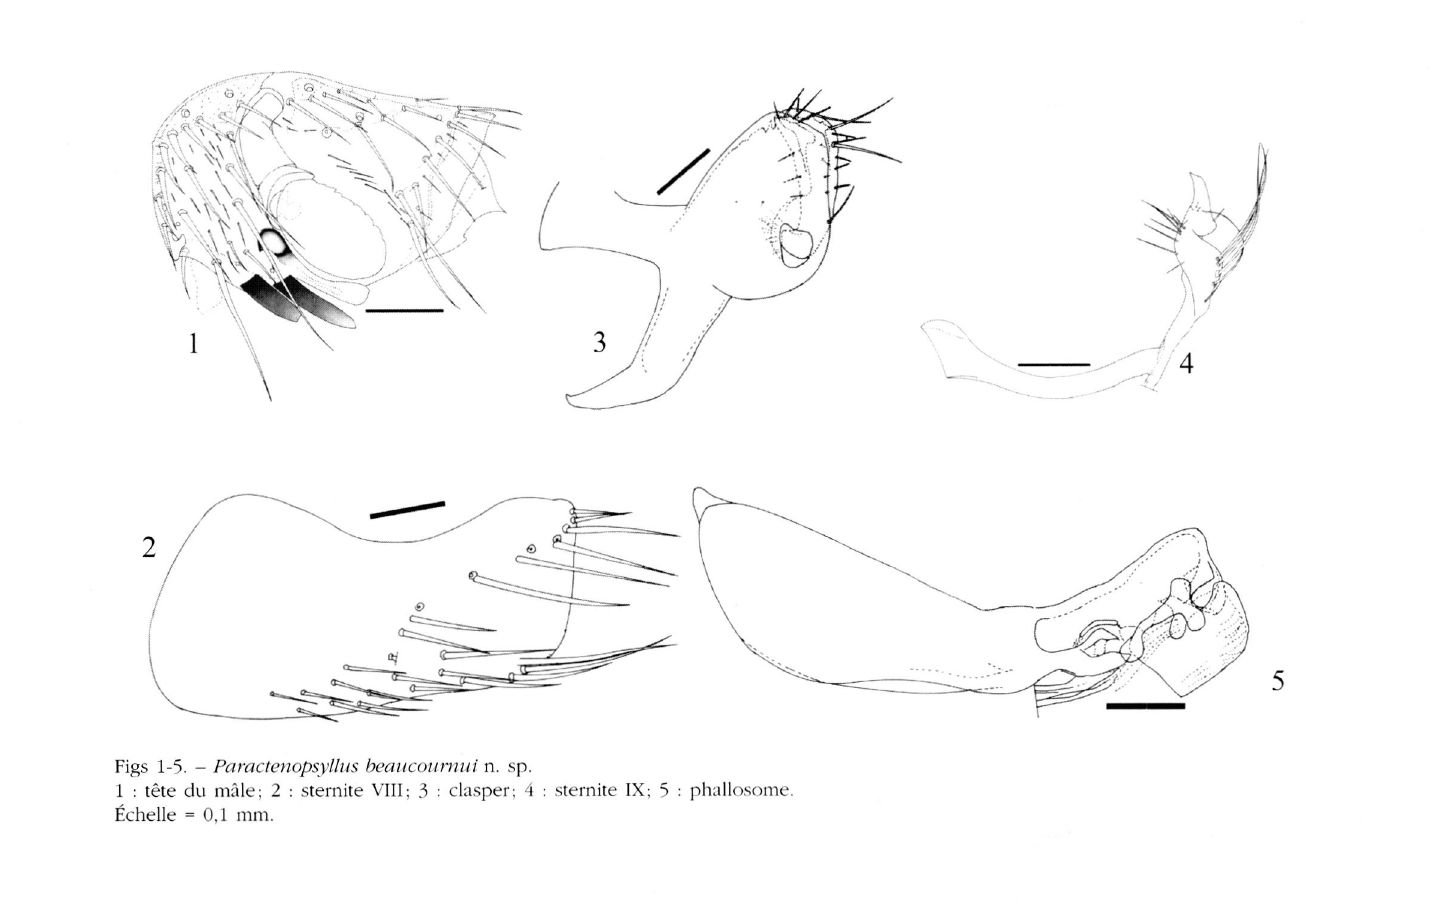
Figs 1-5. - Paractenopsyllus beaucournui n. sp. 1 : tête du mâle; 2 : sternite VIII; 3 : clasper; 4 : sternite IX; 5 : phallosome. Échelle = 0,1